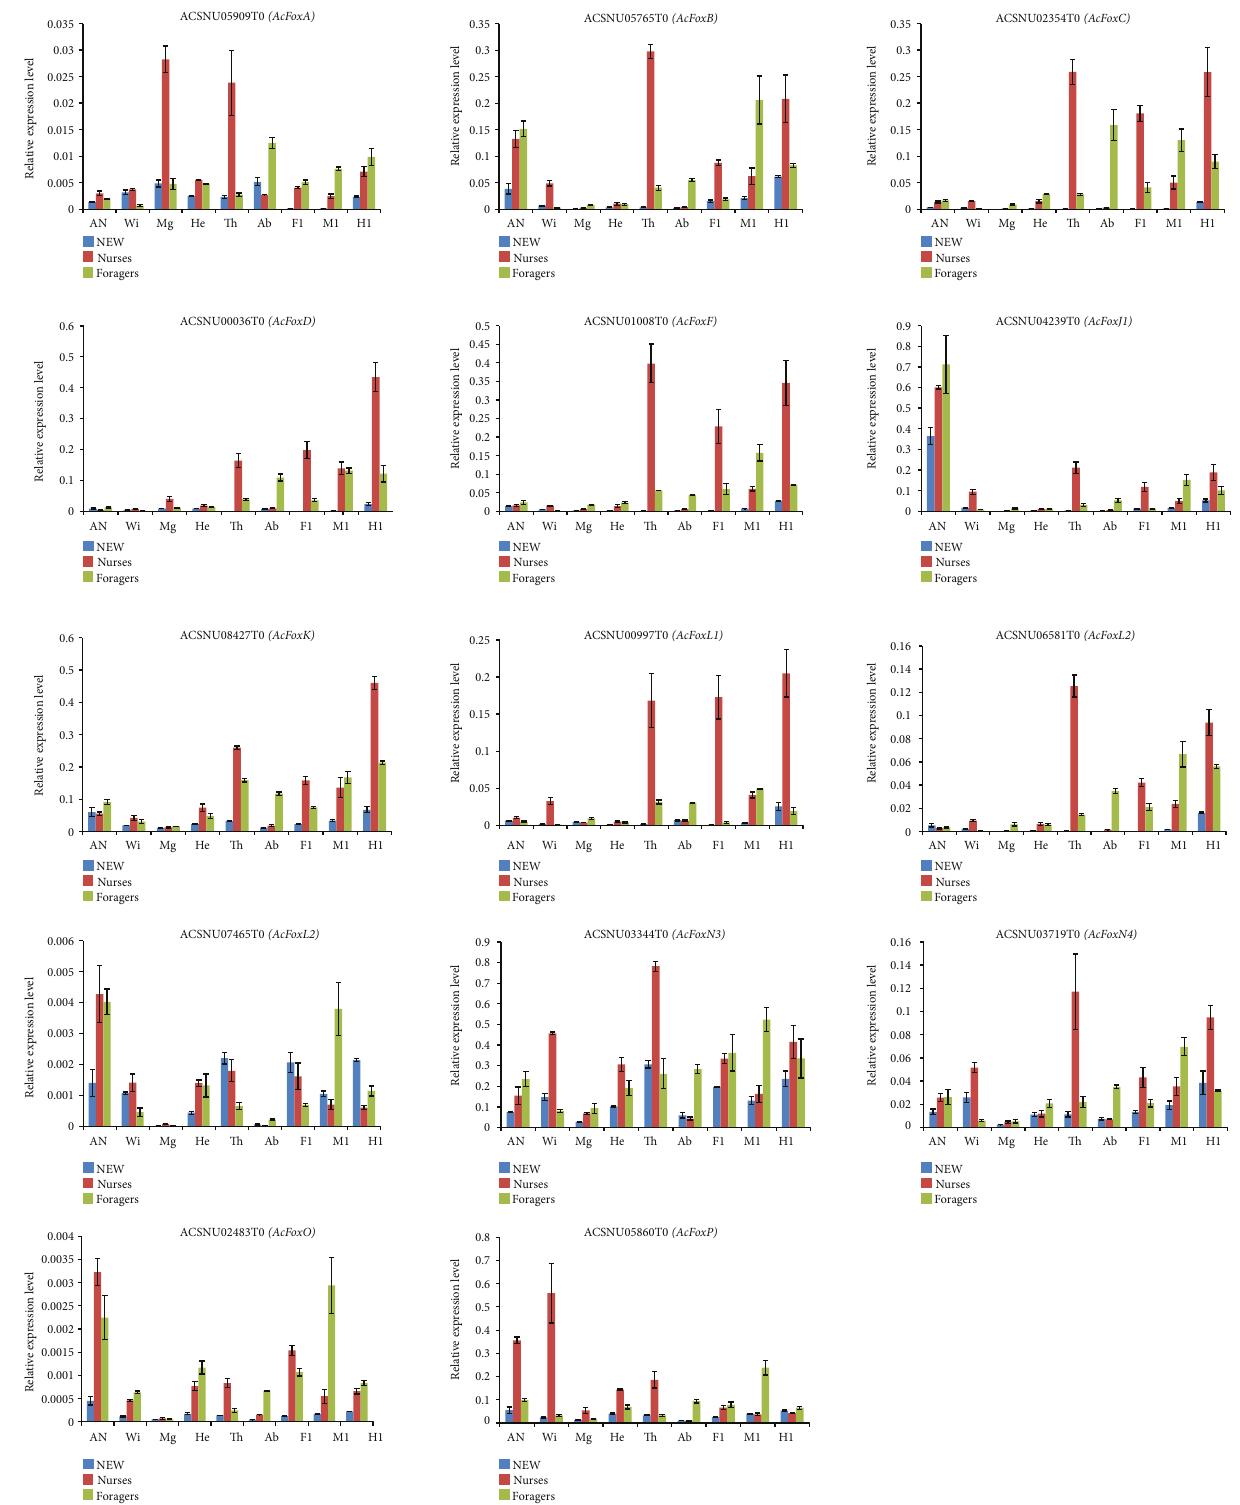
Figure 4: The tissue expression pro fi les of A. cerana Fox family genes in the development of newly emerged workers (NEW), nurses, and foragers. The cDNA templates were derived from the antennae (An), wings (Wi), midgut (Mg), head (He), thorax (Th), abdomen (Ab), front legs (Fl), middle legs (Ml), and hind legs